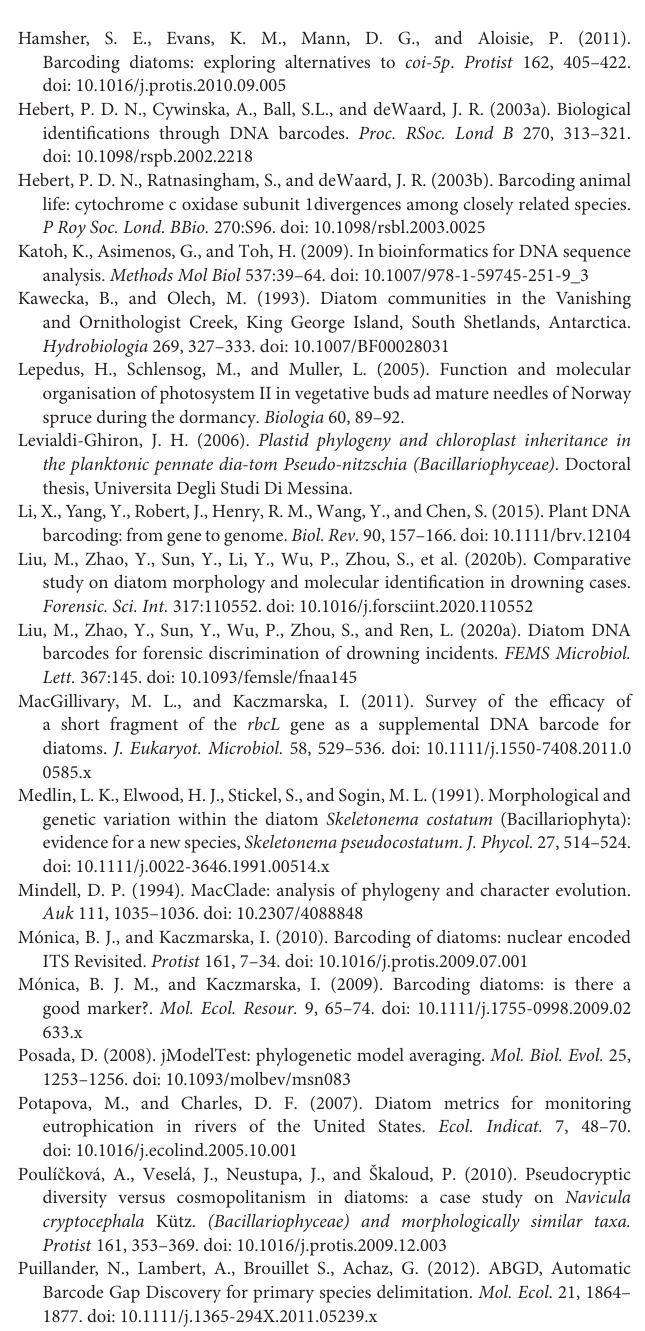
Supplementary Figure 1 | Sampling location from the China coast. Supplementary Figure 2 | Species diversity for each location at the species, genus, and family